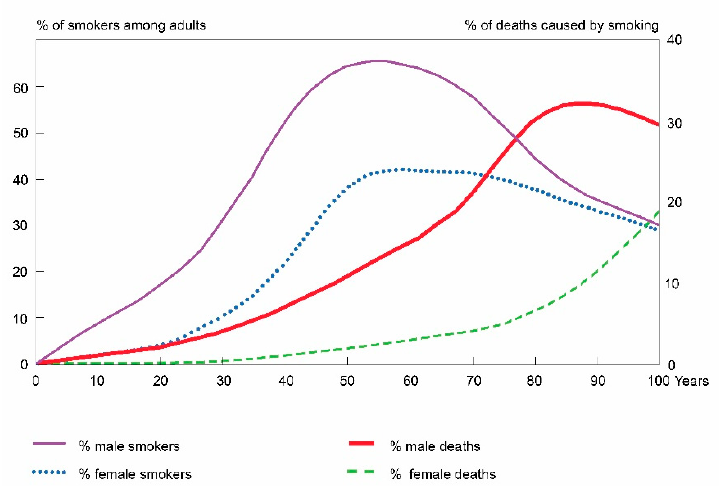
Figure 4. A model of an epidemic of nicotinism. According to Lopez et